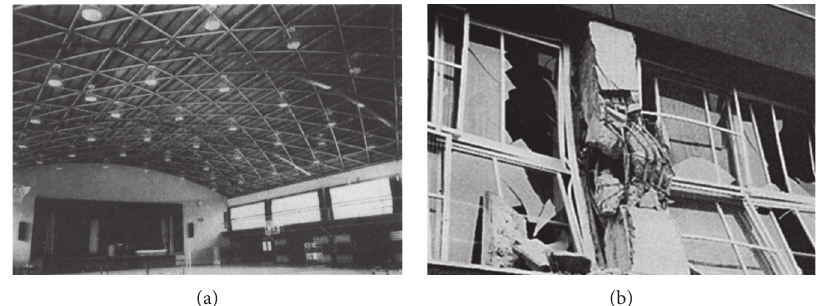
Figure 1: Damage of an RC column of a school gymnasium in Hanshin-Awaji earthquake. (a) Interior view of the high school gym. (b) Damage of a column in the gym.